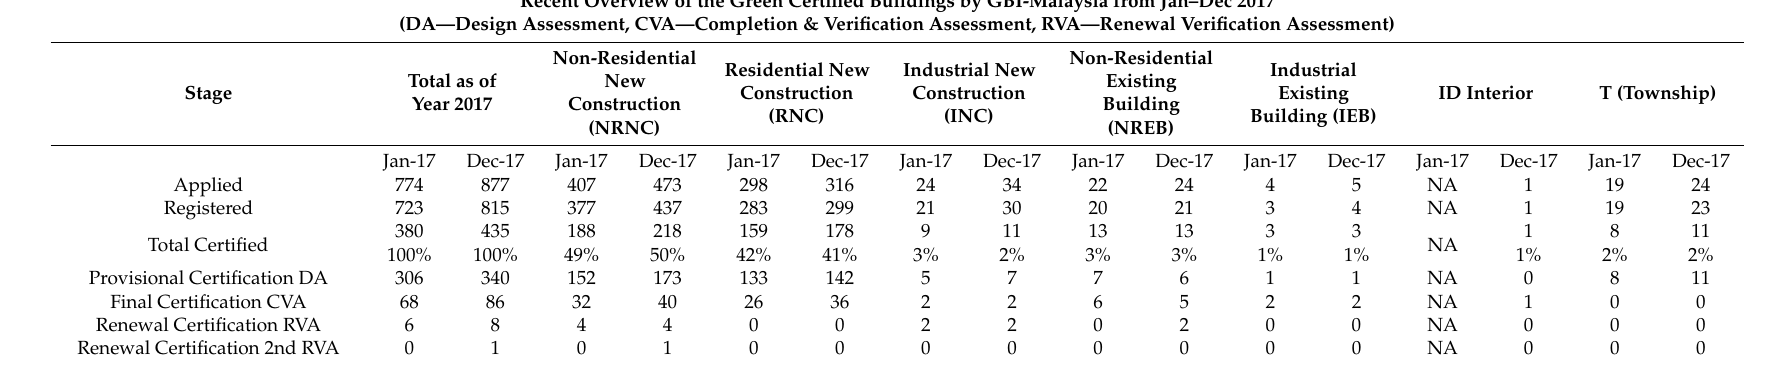
Table 1. Recent Overview of Green Certified Building in